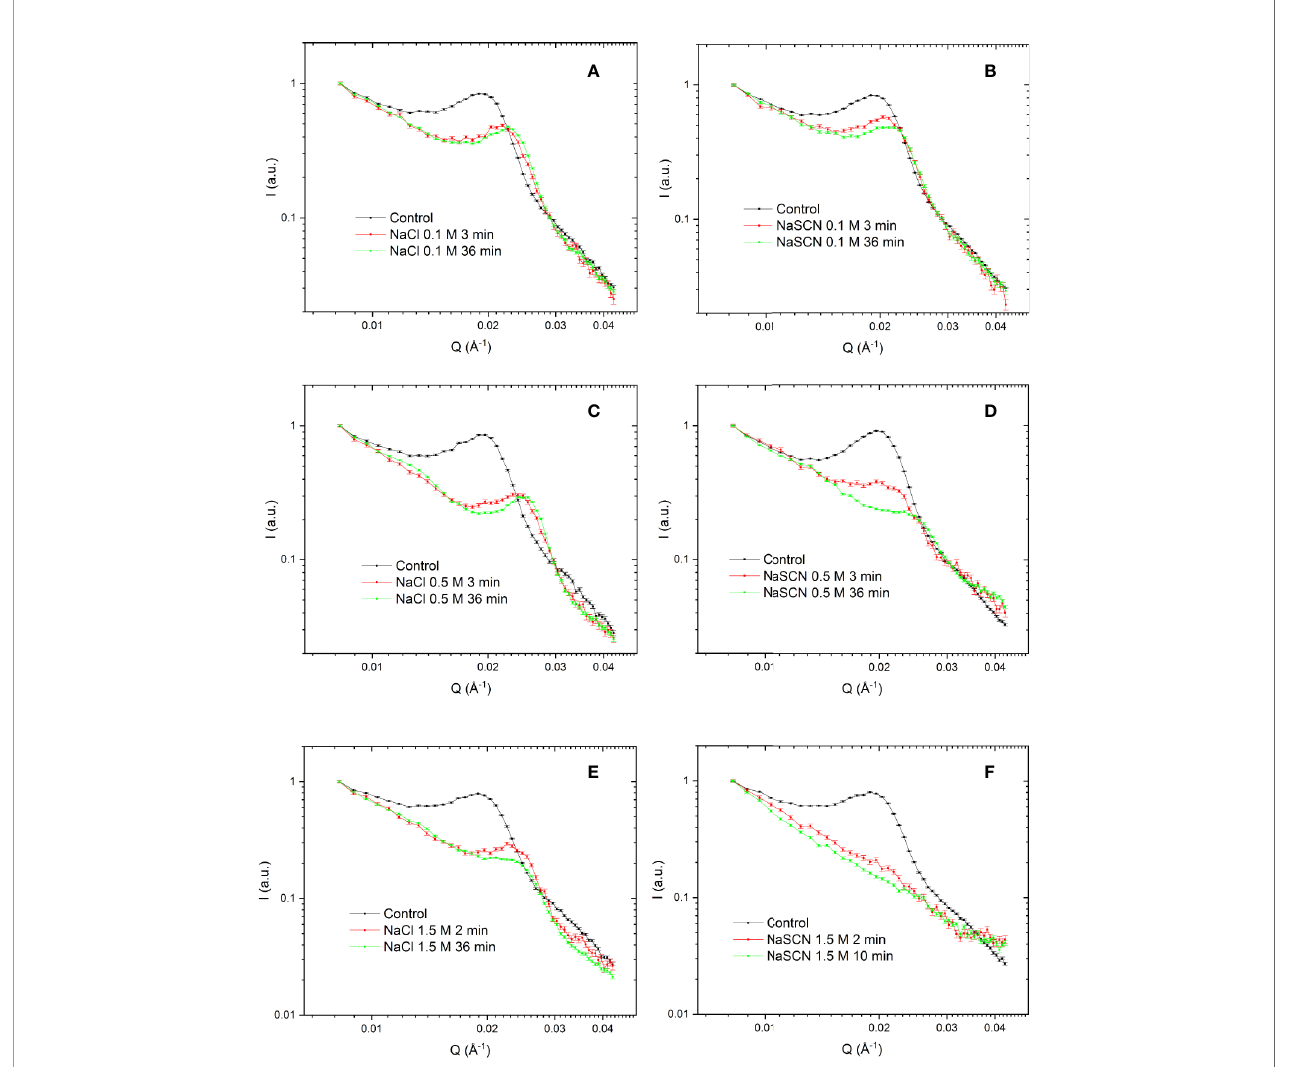
FIGURE 7 | SANS pro fi les of isolated tobacco thylakoid membranes in the absence (control) and presence of different concentrations of NaCl (A , C , E) and NaSCN (B , D , F) recorded at different times after the addition of salts. To optimize the S/N of the SANS curves, different data acquisition and averaging times (1 ‑ 5 min) were applied, dictated by the rate of structural changes induced by NaSCN. The time-labels mark the midtimes between the start and the end of data acquisition. For better comparison all curves are normalized to 1 at Q = 0.00832 Å -1 . Three independent biological replicates were measured and a typical data set is